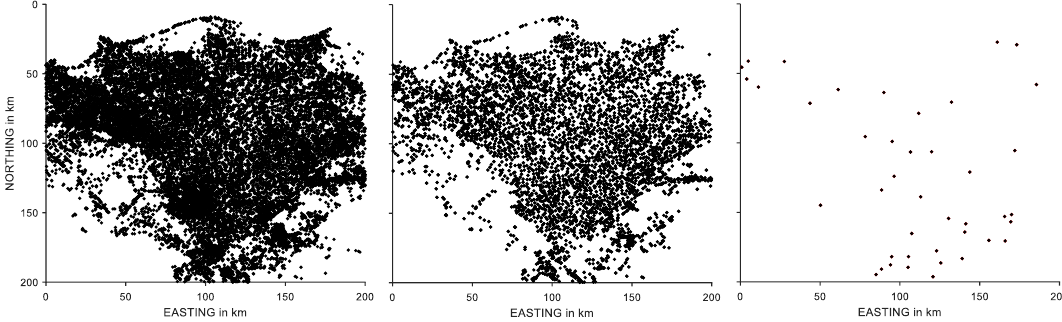
Figure 8. Data points for Class 1 , Class 2 , Class 3 (from left to right ).